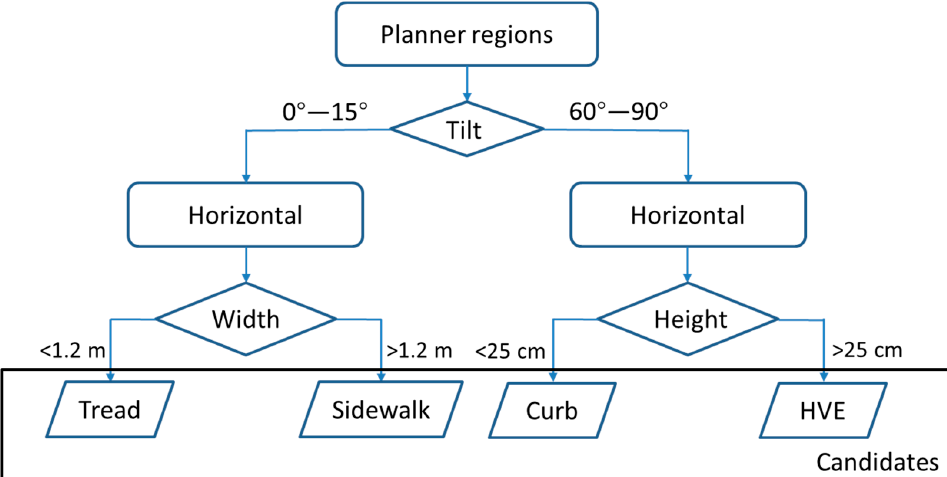
Figure 7. Decision tree for preliminary geometric classification